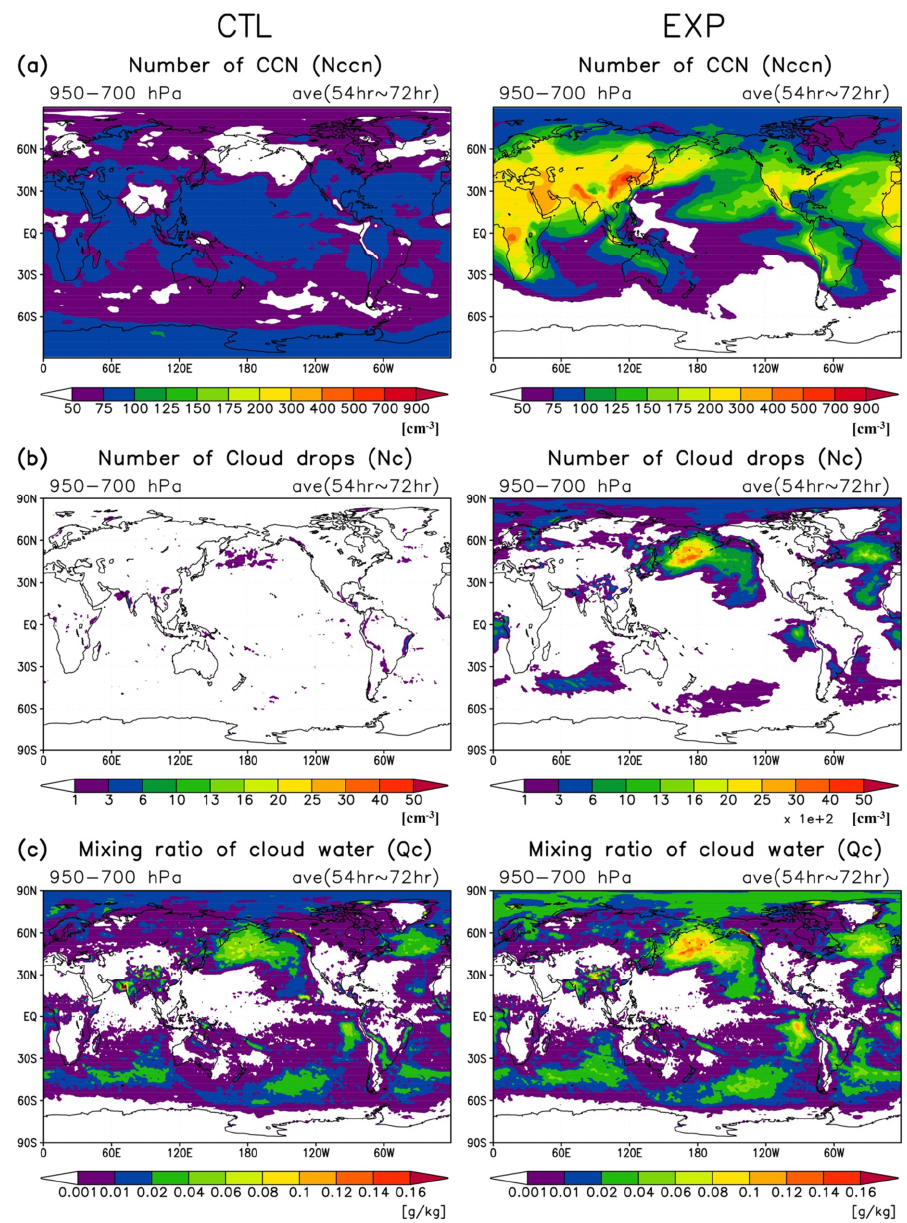
Figure 3. Comparison of ( a ) number concentration of CCN, ( b ) number concentration of cloud droplets, and ( c ) mixing ratio of cloud water averaged from 700 to 950 hPa between the ( left panel ) CTL and ( right panel ) EXP simulations. Table 2. Domain-averaged downward radiation flux at the surface and precipitation amounts for CTL and EXP. 1 Shortwave radiation flux. 2 Longwave radiation